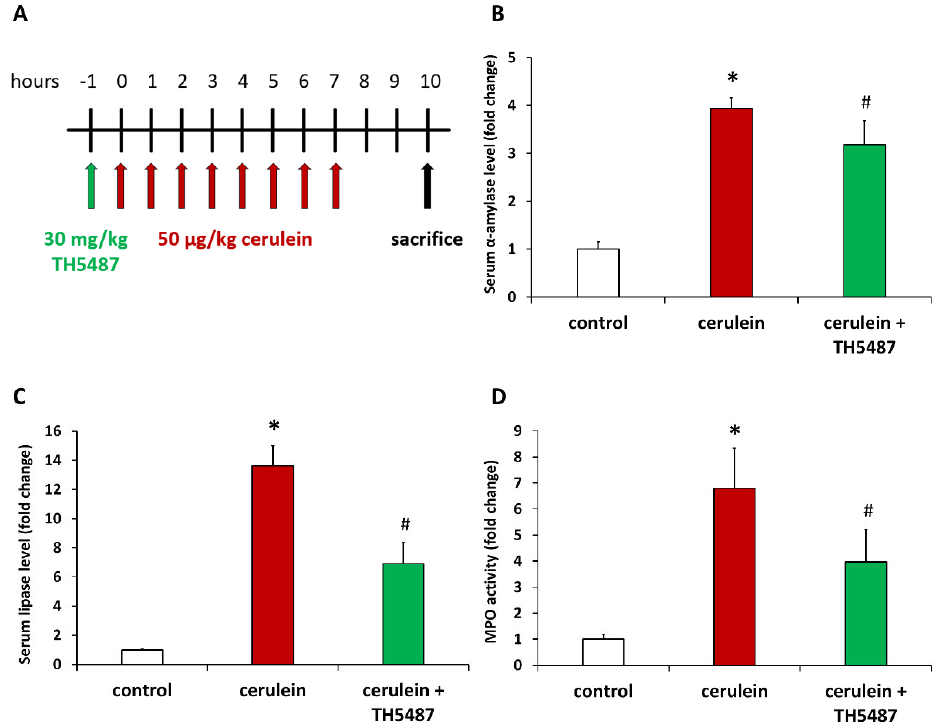
Figure 1. OGG1 inhibition reduces acinar cell injury and inflammatory cell recruitment in cerulein- induced acute pancreatitis. The treatment protocol is presented on panel. Mice were injected i.p. with TH5487 or vehicle 1 h before induction of AP with 8 repeated cerulein injections. Blood and pancreata were collected 10 h after the first cerulein injection when animals were sacrificed ( A ). TH5487 markedly reduced serum amylase ( B ) and lipase levels ( C ) and suppressed leukocyte infil ‐ tration in the pancreas as indicated by decreased MPO levels ( D ). Values represent mean ± SD, n = 6. * p < 0.05 vs. control group, # p < 0.05 vs. cerulein group.